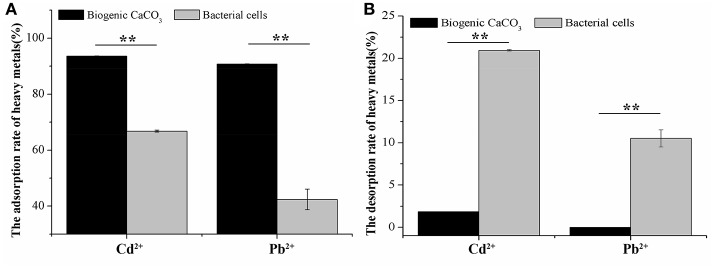
The adsorption and desorption of Cd2+ or Pb2+ by biogenic CaCO3 and bacterial cells. (A) The rate of adsorption (%). (B) The rate of desorption (%). The “*” indicates statistically significant differences between the two treatments (t-test, *p < 0.05, **p < 0.01). Data represent the mean ± SD of three independent experiments.